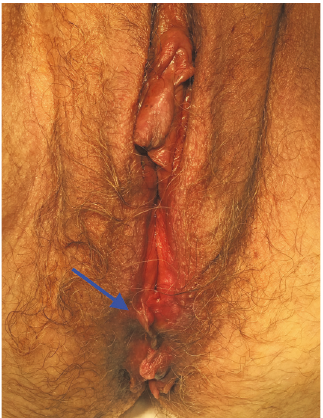
Figure 2: Ectopic breast tissue noted on the vulva as pointed out by the arrow. Image taken with permission from patient at time of